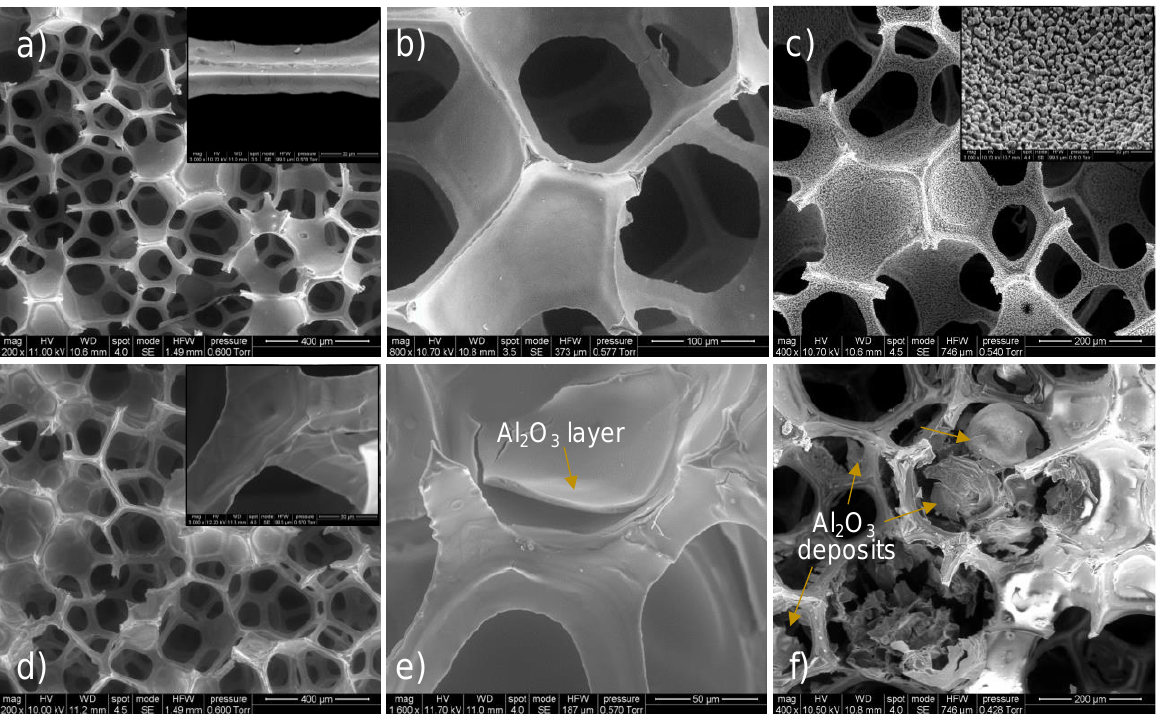
Figure 4. SEM images at different magnification showing the morphology of bare F1200 ( a , and its inset), F1500 ( b ) and F1800 ( c , and its inset) SiC foams supports as well as RuA-F1200 ( d , and its inset; e ) and RuA(N)-F1200 ( f ) catalysts where an Al 2 O 3 overlayer was deposited by dip-coating or macropore filling, respectively.